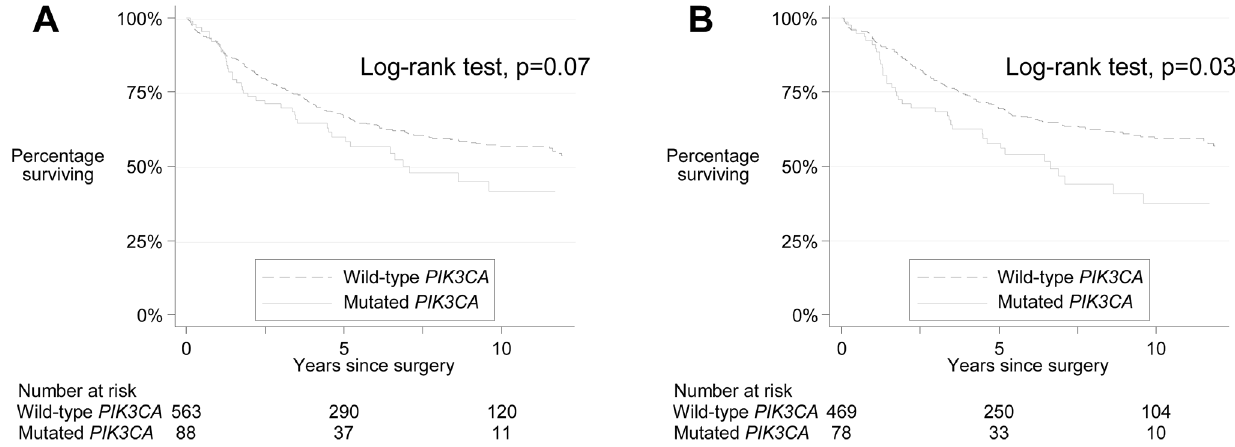
Figure 4. Kaplan-Meier survival curves showing overall survival according to PIK3CA mutation status (wild-type versus mutated) in (A) all colorectal carcinoma patients and (B) only in patients with BRAF wild-type